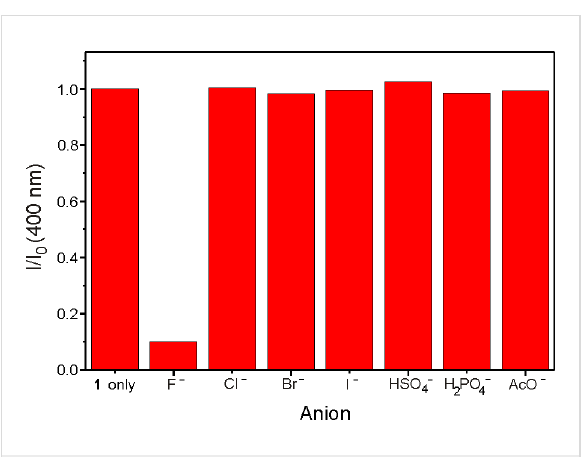
Figure 4: Comparison of fluorescence emission of 1 (5 μ M) in CH 3 CN after the addition of 50 equiv of tetrabutylammonium salts. The F − titration experiments were carried out in CH 3 CN for